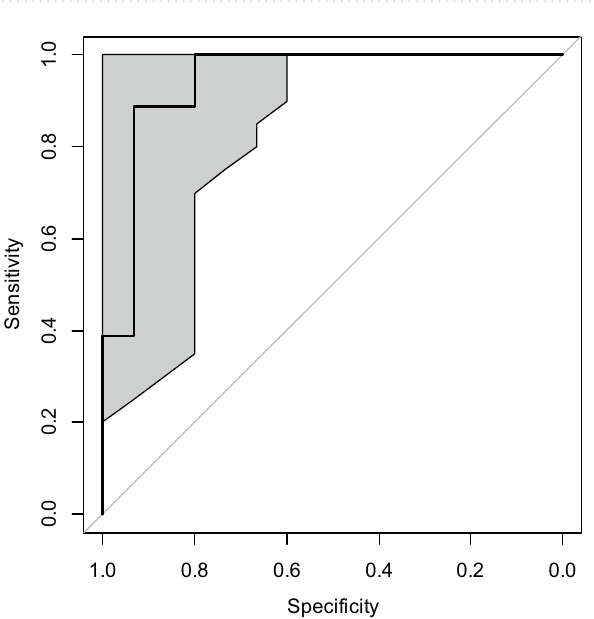
Figure 6. ( A ) Actual versus reconstructed Dose on testing data, based on the RF algorithm. Overall R 2 = 0.738, root mean squared error (RMSE) = 1.060 Gy, mean absolute error (MAE) = 0.749 Gy. Among the 0 Gy samples, RMSE = 0.978 Gy and MAE = 0.601 Gy. Among the 2.0–2.5 Gy samples, RMSE = 0.824 Gy and MAE = 0.684 Gy. Among the 5.0 Gy samples, RMSE = 1.385 Gy and MAE = 0.971 Gy. ( B ) Actual versus reconstructed Interaction (= Dose/2 for PBI, = Dose for TBI). Overall R 2 = 0.868, RMSE = 0.663 Gy, MAE = 0.472 Gy. Among the 0 Gy samples, RMSE = 0.560 Gy and MAE = 0.332 Gy. Among the 2.0–2.5 Gy samples, RMSE = 0.677 Gy and MAE = 0.516 Gy. Among the 5.0 Gy samples, RMSE = 0.826 Gy and MAE = 0.665 Gy.